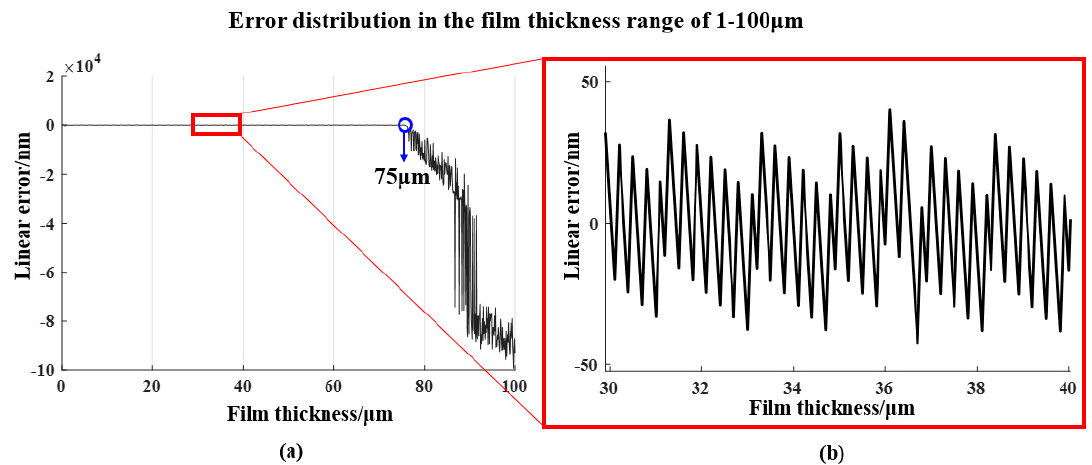
Figure 6. The influence of thin-film thickness on the calculation error. ( a ) Error distribution in the film thickness range of 1–100 μ m. ( b ) Error within effective range fluctuates periodically within 50 nm.